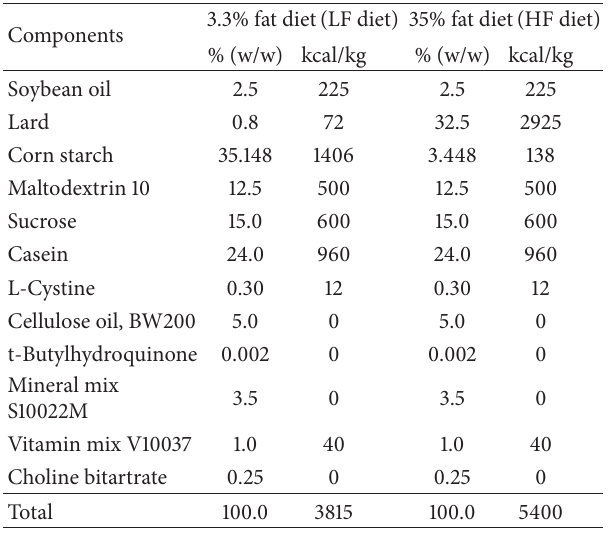
Table 1: Composition of experimental